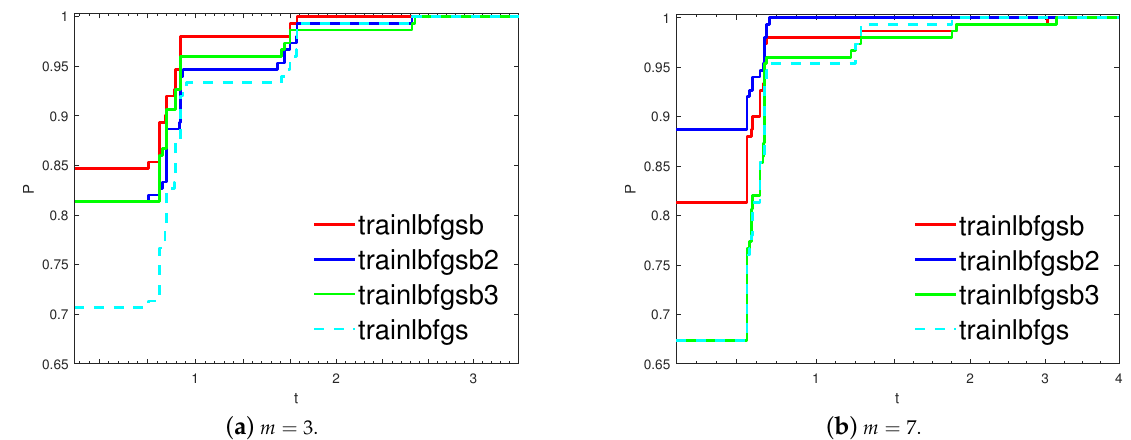
Figure 2. Log 10 scaled performance profiles based on F 1 -score for the breast cancer classification